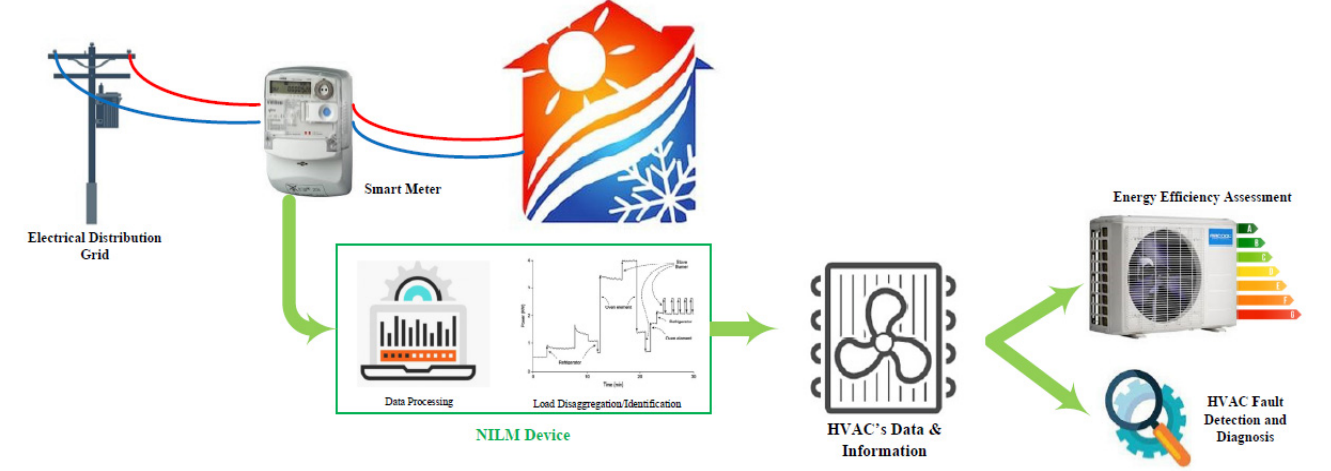
Figure 1. A general framework for energy efficiency assessment and FDD methods using NILM- based strategies.